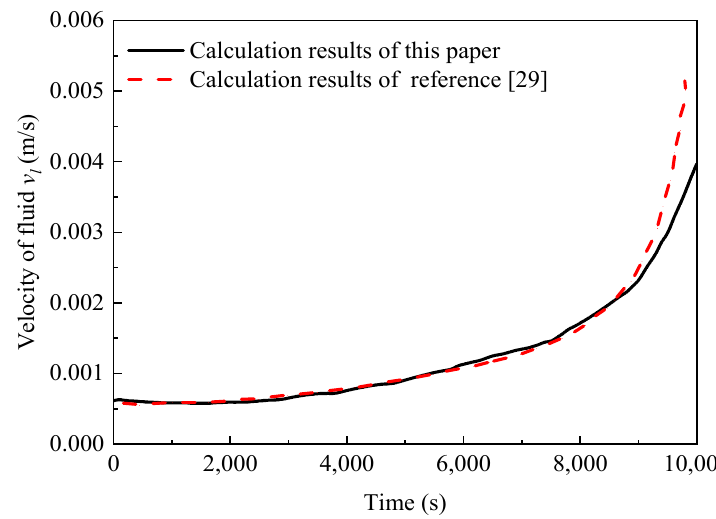
Figure 5. Evolution curves of porosity at inner boundary.